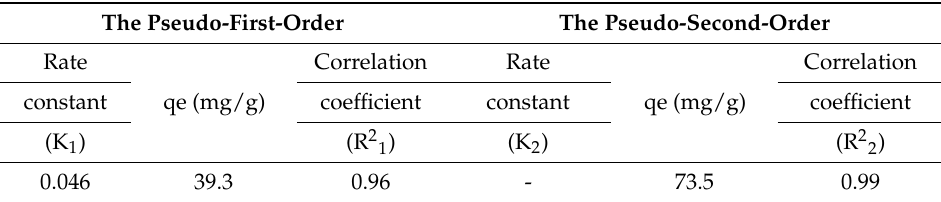
Table 1. Kinetic constants for Hg(II) adsorption onto IL-ACMRW—Ionic liquid modified activated carbon from mixed recyclable waste.